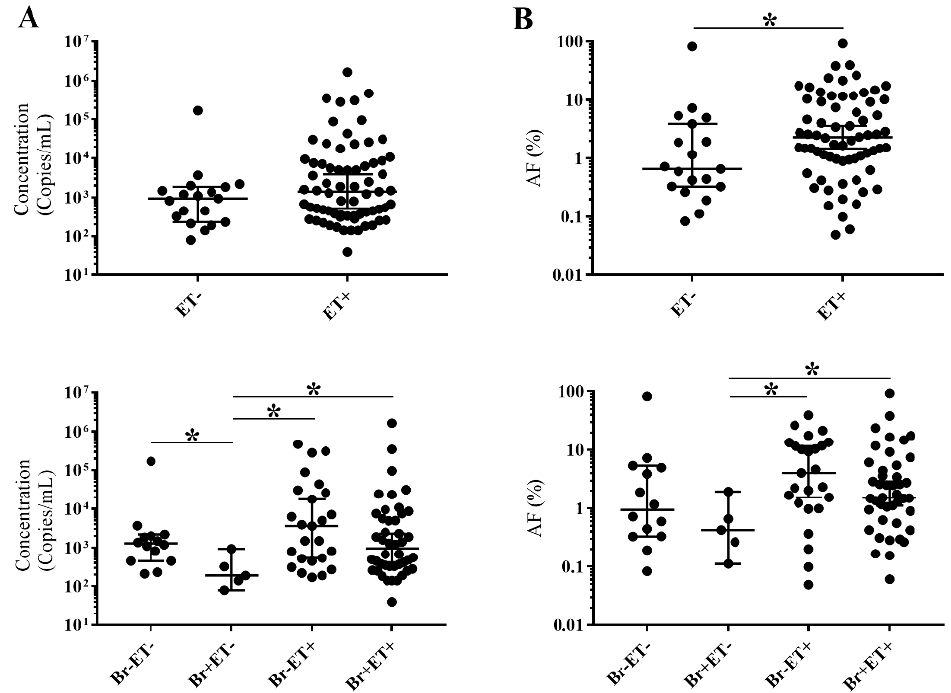
Figure 1. Influence of metastases on detectable EGFR mutated ctDNA levels. ( A ) distribution of concentration (copies/mL); ( B ) distribution of allele frequency (%); Br: brain metastases; ET: extrathoracic metastases; AF (%): percentage of allele frequency; +: present; − : absent; median with 95% confidence interval (CI); * p < 0.05.